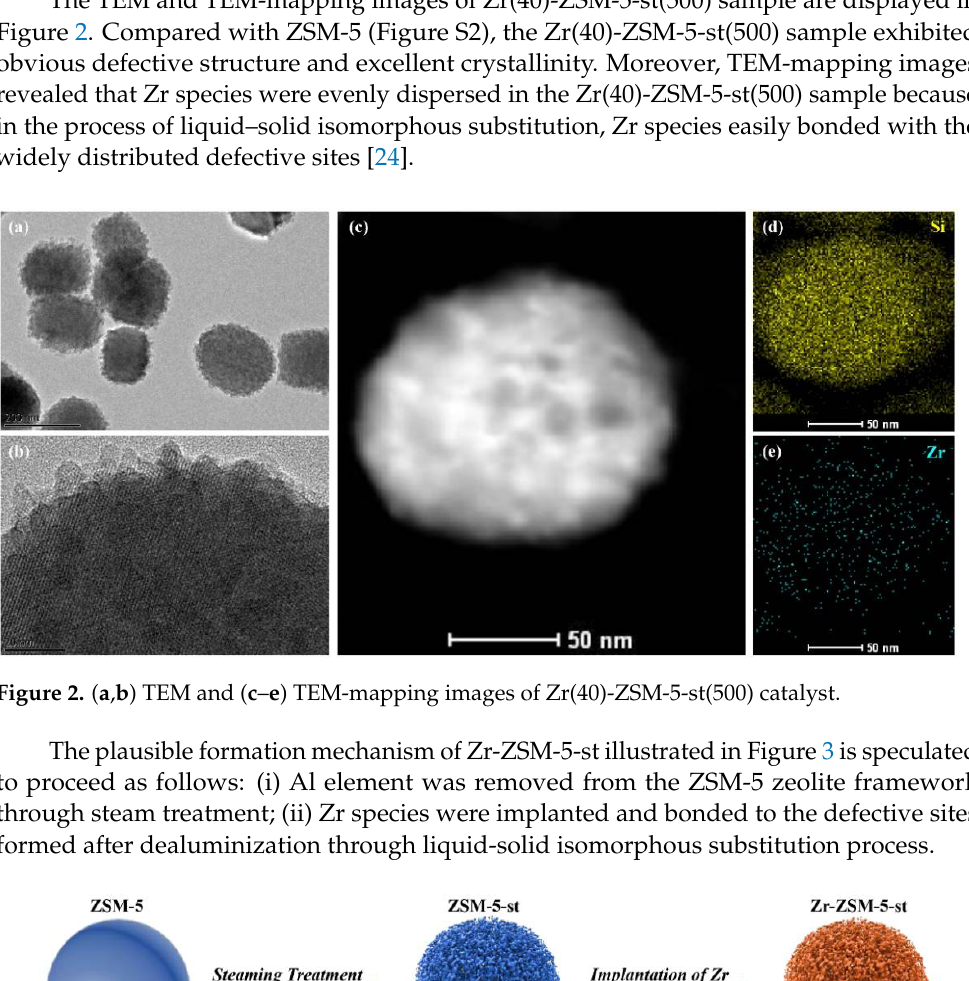
Figure 4. ( a ) Zr 3d XPS spectra for Zr(40)-ZSM-5-st(500) catalyst as well as ZrO 2 . ( b ) NH 3 -TPD spec- tra for Zr(40)-ZSM-5-st(500) together with ZSM-5 catalysts. Esterification reaction performance is closely related to the acid properties of the cat- alyst. NH 3 -TPD was adopted in Figure 4b to determine the total acidity of Zr(40)-ZSM-5- st(500) and ZSM-5 samples. Both samples exhibited an NH 3 desorption peak at 140–160 °C, which can be associated with weak acid centers. ZSM-5 exhibited the moderate-strong acid desorption peak at 339 °C, whereas Zr(40)-ZSM-5-st(500) revealed a moderate-strong acid desorption shoulder peak shift to a temperature of 253 °C, which was caused by the dealuminization during steam treatment [25]. Furthermore, Zr(40)-ZSM-5-st(500) exhib- ited a strong acid desorption peak at 689 °C, which was attributed to the superacid site formed by the implanted Zr binding with the zeolite defective sites after steam treatment. Thus, through steam treatment and liquid–solid isomorphous substitution, Zr 4+ spe- cies were introduced into the ZSM-5 zeolite framework. Moreover, for the Zr(40)-ZSM-5- st(500) sample, excellent crystallinity was maintained, mass transfer ability was improved, and Zr 4+ species were evenly dispersed into the zeolite framework. Furthermore, Zr(40)- ZSM-5-st(500) sample exhibited strong acid strength because of the implanted Zr species.